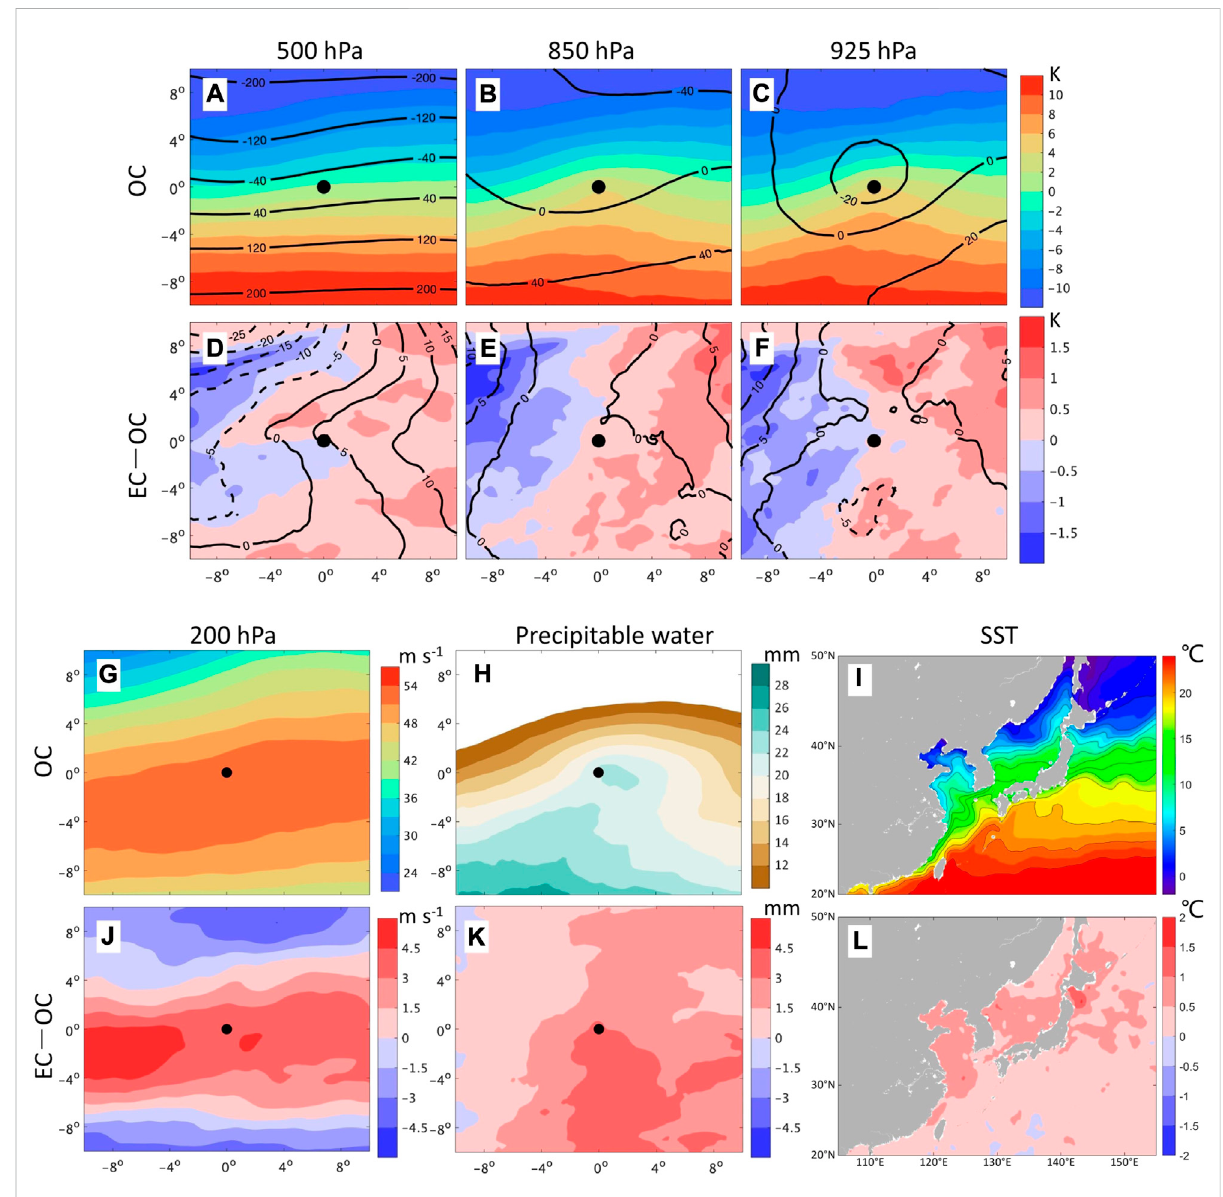
FIGURE 4 Comparison of initial conditions for OCs and ECs. The fi rst row shows average potential temperature anomaly (shadings) and GPH anomaly (gpm; contours) for OCs at 500 (A) , 850 (B) , and 925 (C) hPa. The second row shows the difference in average potential temperature anomaly (shadings) and GPH anomaly (gpm; contours) between ECs and OCs at 500 (D) , 850 (E) , and 925 (F) hPa. The third row shows the average 200 hPa wind speed (G) and precipitable water (H) for OCs. The fourth row shows the difference in average 200 hPa wind speed (I) and precipitable water (J) between ECs and OCs. Black dots locate the cyclone